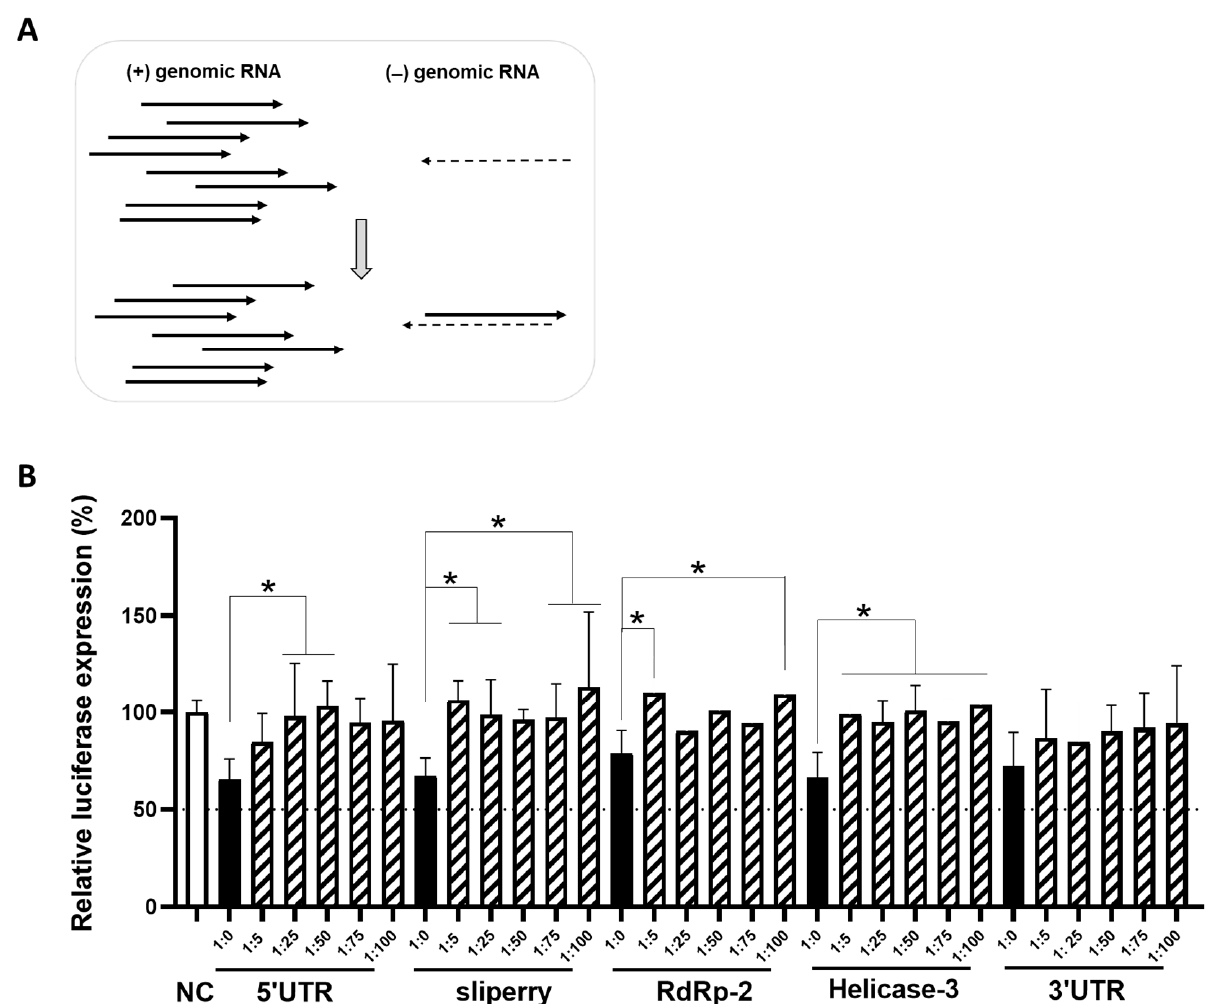
Figure 7. The impact of Cas13 on the intermediate minus sense transcripts. ( A ) Schematic representation of differences between +RNA and –RNA strands during SARS-CoV-2 RNA replication. +RNA strands (black arrows) are far more abudant than the –RNA strands (black dashed arrows). The less abundant –RNA strands are present as double-stranded replicative forms during RNA replication. The slippery sequence is represented as a stable double-stranded RNA structure. The presence of such stable RNA structures may affect intermolecular base pairing of the perfect +/- RNA duplex; ( B ) The efficiency of crRNAs targeting -RNA targets when annealed to complementary +RNA targets. The efficiency of six crRNAs was tested in HEK293T cells by co- transfecting them with a mixture of different ratios of − and + luciferase constructs (1:5, 1:25, 1:50, 1:75 and 1:100 of − luciferase construct: + luciferase construct) or with the − luciferase construct alone. To quantify viral gene expression, luciferase level was measured at two days after transfection. Mean values (±SD) of three experiments in duplicates are shown. The average luciferase levels are expressed as percentage (%) of luciferase expression, setting the negative control (NC) at 100%. Statistical significance was determined using one-way ANOVA, * p ≤ 0.05.